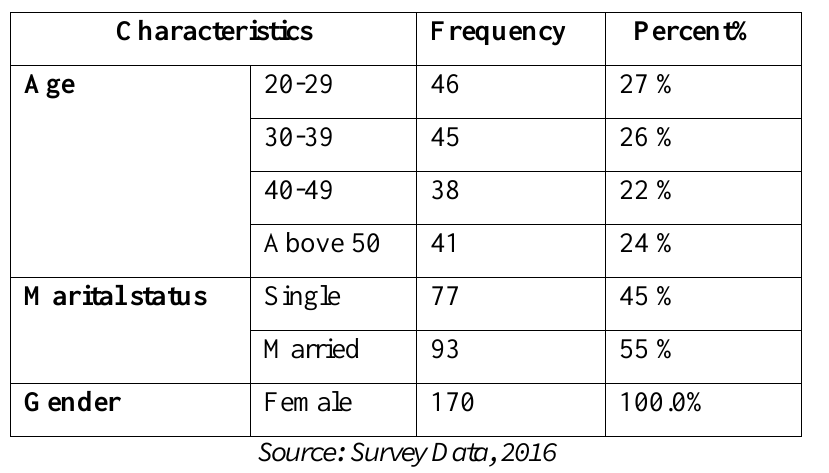
Table 1: Descriptive statistics for